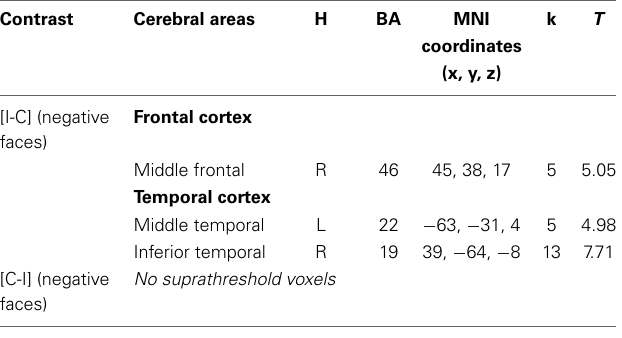
Table 7 | Brain regions activated during the emotional Stroop task with negative faces in drug-on parkinsonian